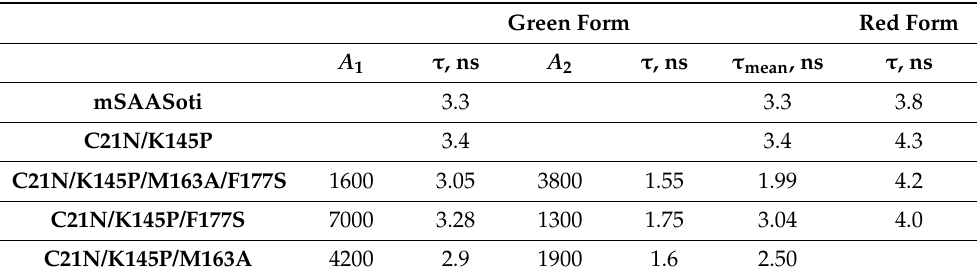
Table 2. Fluorescence lifetimes of mSAASoti and the mutants calculated according to Equation (1). Excitation wavelengths were 480 nm and 532 nm for green and red forms, respectively. Emission for both forms was registered at the maximum emission wavelength. The protein solutions were